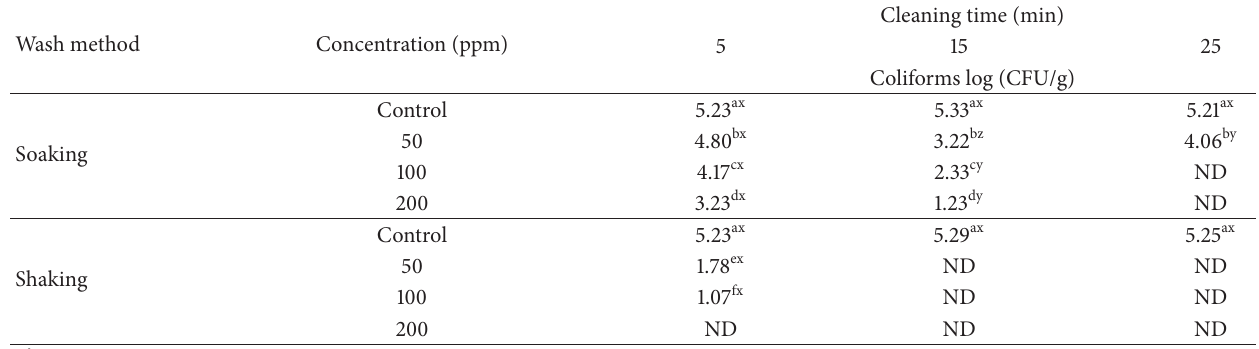
Table 4: Coliform reduction of tilapia fillets disinfected by soaking or shaking treatments at different chlorine dioxide concentrations. Wash